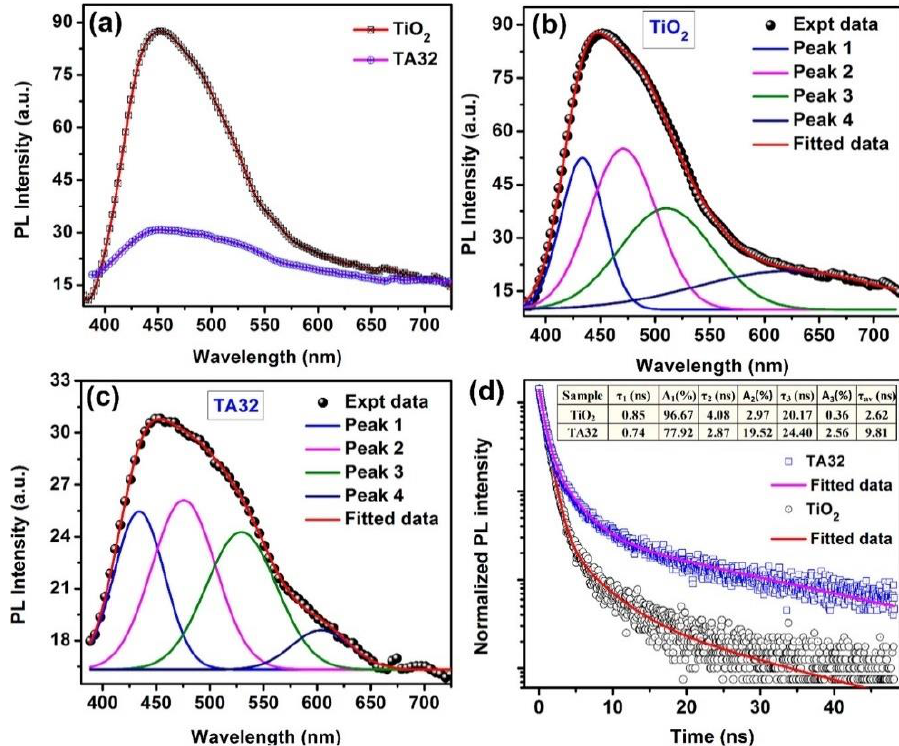
Figure 16. Photoluminescence is a useful technique to probe electronic interactions in plasmonic nanostructures, including the nature of defects, kinetics of charge recombination, and the migration of photogenerated charge carriers, as presented in the work of Paul et al. [194] ( a ) shows a comparison of PL spectra of pure TiO 2 with that of the composite Ag–TiO 2 excited using a 355 nm laser. It is noted that the PL intensity is highly reduced in the heterostructure, due to the introduction of Ag nanoparticles. Gaussian fitted PL spectra of TiO 2 nanorods and the Ag–TiO 2 heterostructure are respectively shown in ( b , c ). The PL intensity of the TiO 2 nanorods is also seen to have decreased by ~3 times after decoration by Ag nanoparticles, while the PL spectra remain the same. By identifying the centers of the deconvoluted peaks in ( b , c ), Paul et al. are able to elicit the different characteristics of the given samples, such as self-trapped excitons at the TiO 2 octahedra (Peak 1), shallow traps involving Ti 3+ states below the conduction band (Peak 2), deep trap states associated with single electron trapped oxygen vacancies (Peak 3), and an intrinsic defect (Peak 4). Lastly, ( d ) provides a comparison of time-resolved photoluminescence spectra of pure TiO 2 nanorods and the Ag–TiO 2 heterostructure at 471 nm (emission) with 375 nm excitation. From this the lifetime of charge carriers in the different samples can be measured. Reprinted with permission from Ref [194] Copyright American Chemical Society (2017).